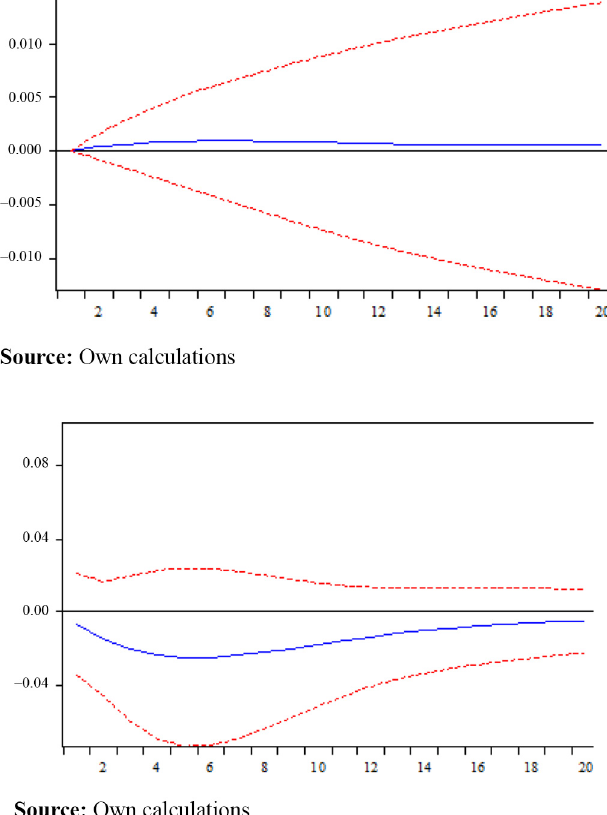
Figure 12. Response of LEDG to